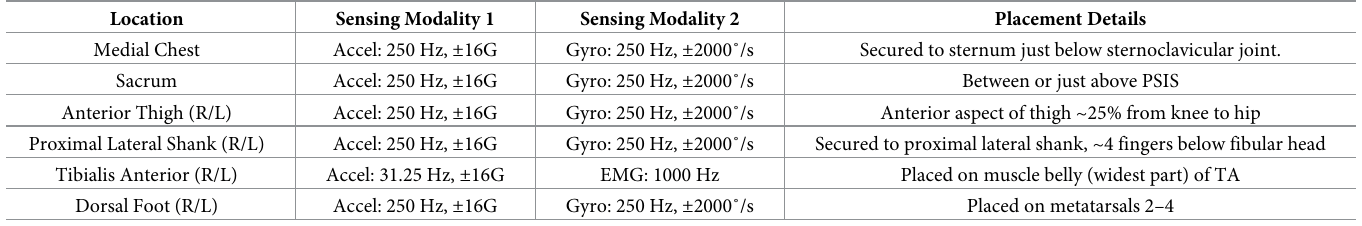
Table 2. Sensor Placement.